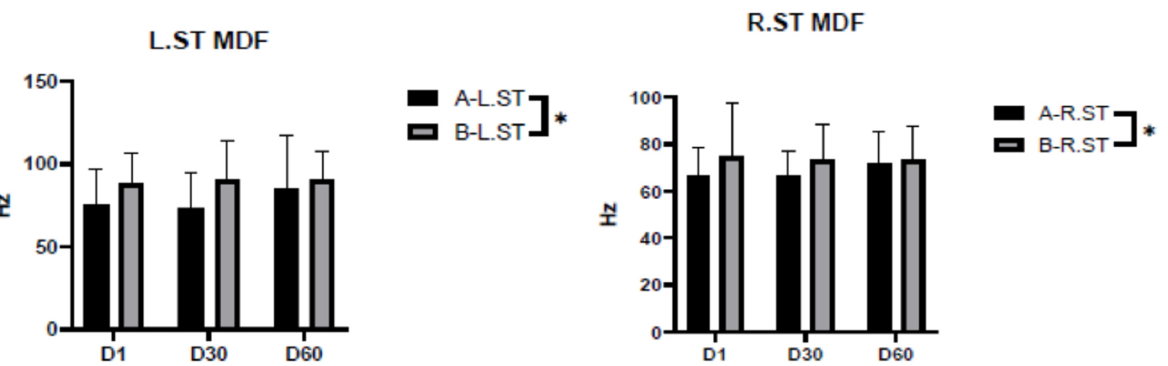
Figure 5. Median frequency (MDF) of the semitendinosus while wearing shooting shoes and while wearing sports shoes. Note: * indicates p < 0.05, which is significant; A indicates shooting shoes; B indicates sports shoes; L indicates left; R indicates right; ST indicates semitendinosus; and D1/D30/D60 indicate times.